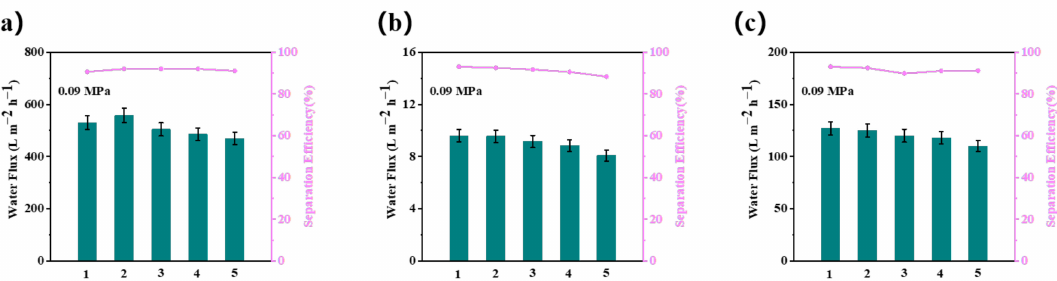
Figure 8. The cycle flux and separation efficiency of M1 when separating an oil-in-water emulsion of ( a ) soybean, ( b ) petroleum ether, and ( c )